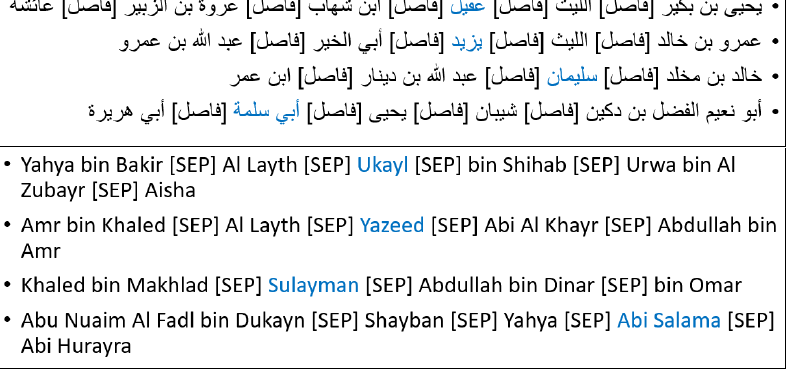
Figure 10. Examples of narrators whose true identities were not on top but were still in the five most probable